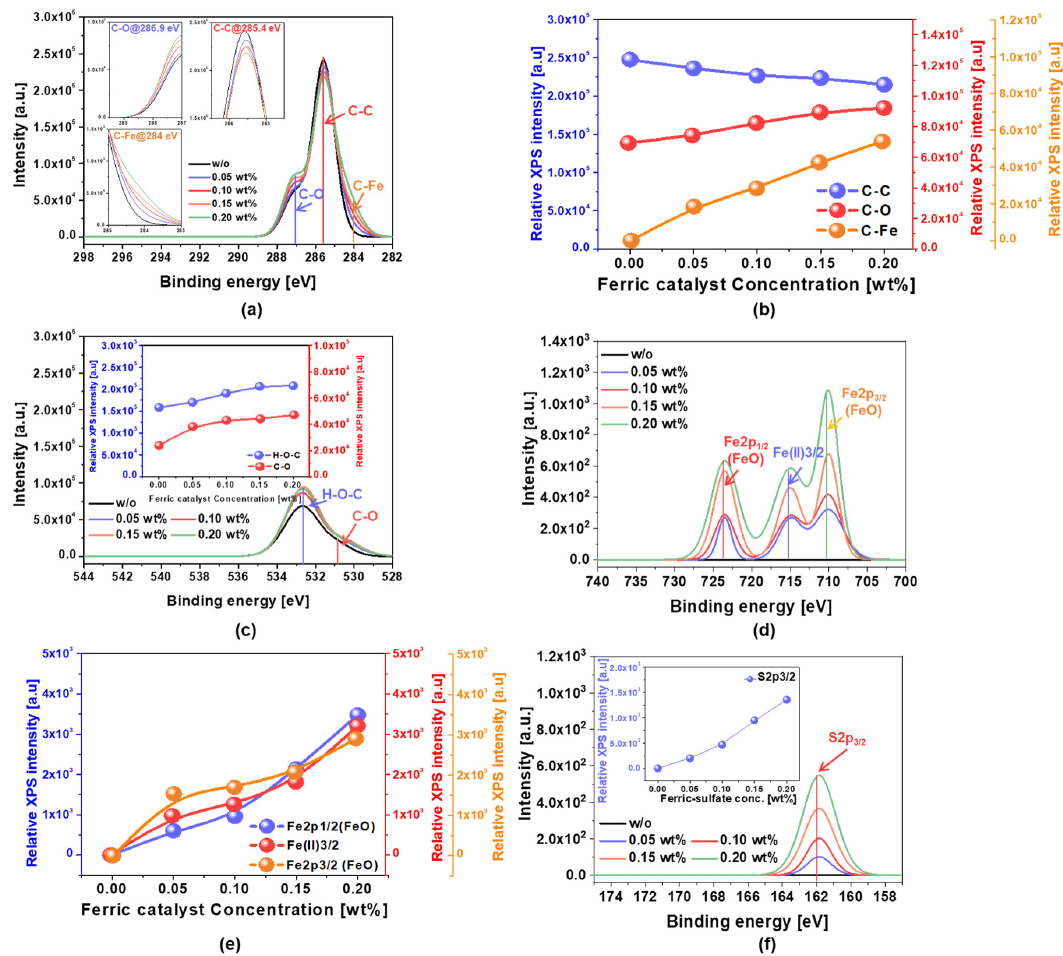
Figure 3. Dependency of the chemical compositions on the ferric catalyst concentration for the polished SOC film surface after CMP, analyzed by XPS. ( a ) C 1s spectra, ( b ) relative XPS intensity for C 1s spectra depending on the ferric catalyst concentration, ( c ) O 1s spectra, ( d ) Fe 2p spectra, ( e ) relative XPS intensity for Fe 2p spectra depending on the ferric catalyst concentration, and ( f ) S 2p